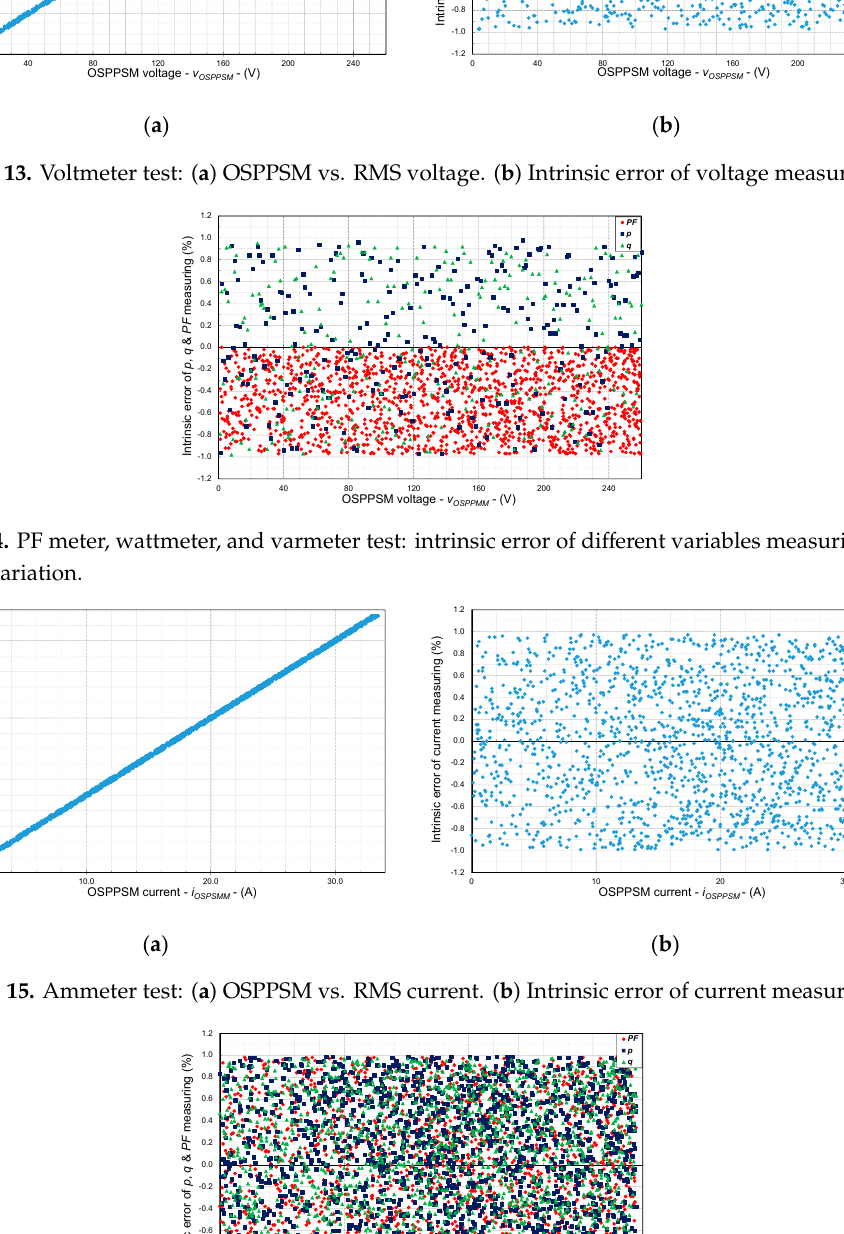
Figure 16. PF meter, wattmeter, and varmeter test: intrinsic error of di ff erent variable measuring for current variation.